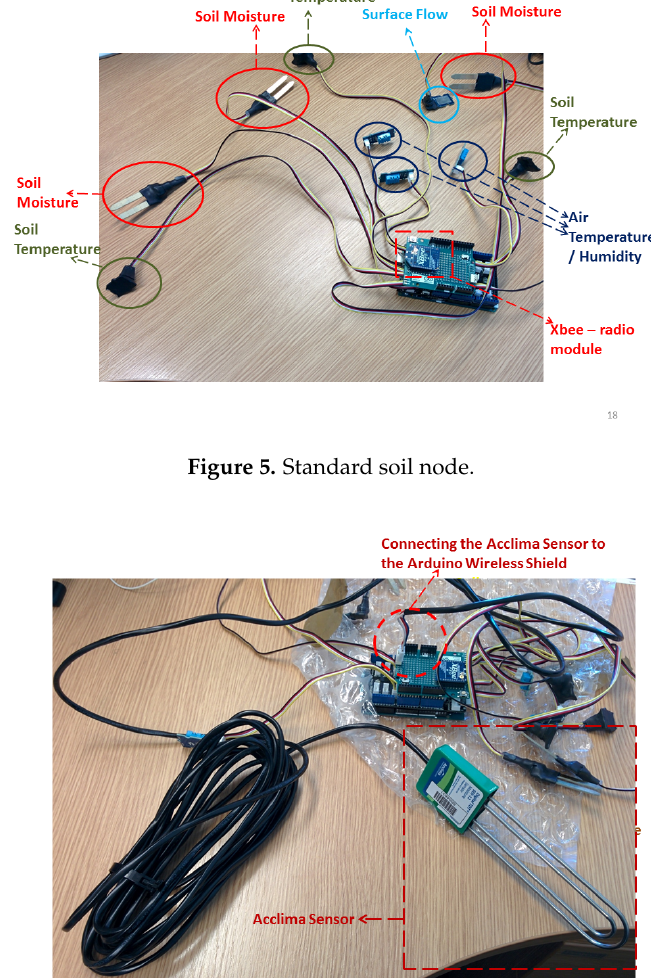
Figure 6. Super soil